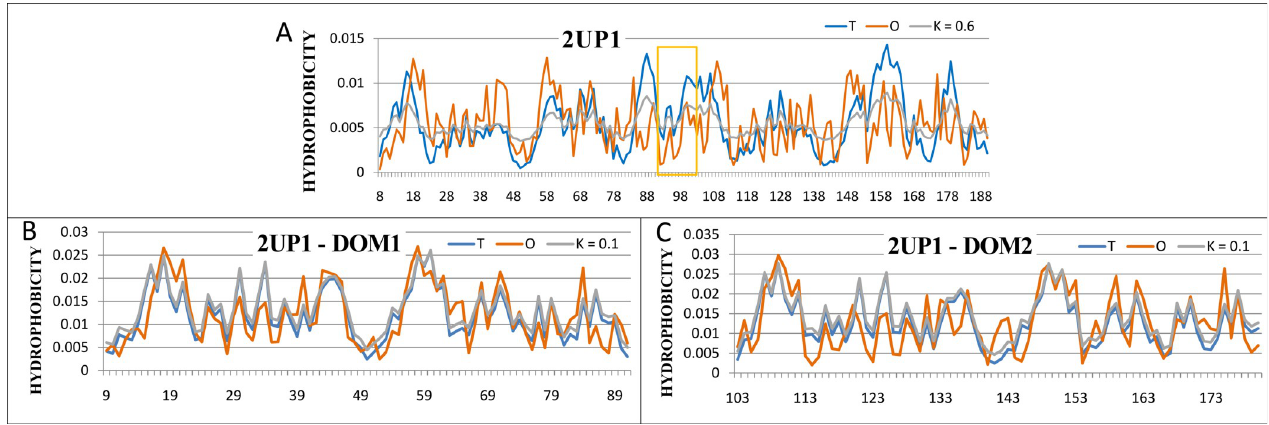
Fig 5. The distributions T , O , M for two-RRM domains of hnRNPA1 (PDB ID - 2UP1). A–a whole chain treated as a structural unit for the FOD calculation; segment IDR is marked by a box); B. C–the two domains treated as independent structural units.